Question: Condense the content of this figure into a single sentence.
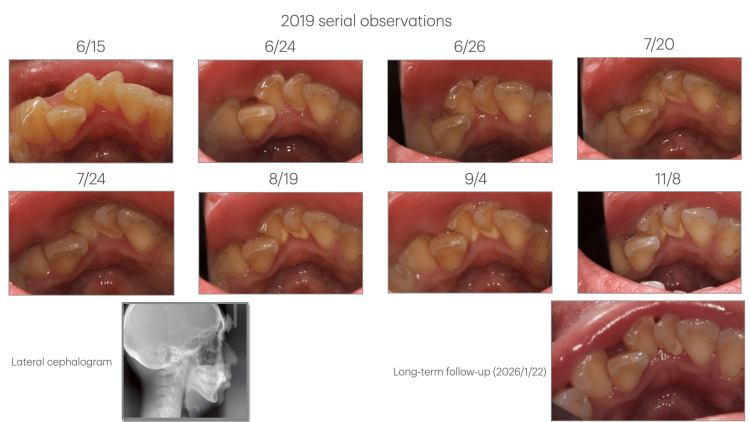
Answer: Serial intraoral observations in 2019 and long-term follow-up findings in Case 2 Upper two rows: serial intraoral photographs obtained in 2019, showing gradual re-accumulation of calculus on the lingual surfaces of the mandibular anterior teeth over time after scaling. Lower left: radiographic image obtained prior to the 2019 observation period. Lower right: long-term follow-up intraoral photograph, showing no clear renewed progressive enlargement compared with the earlier plateau-like stage.